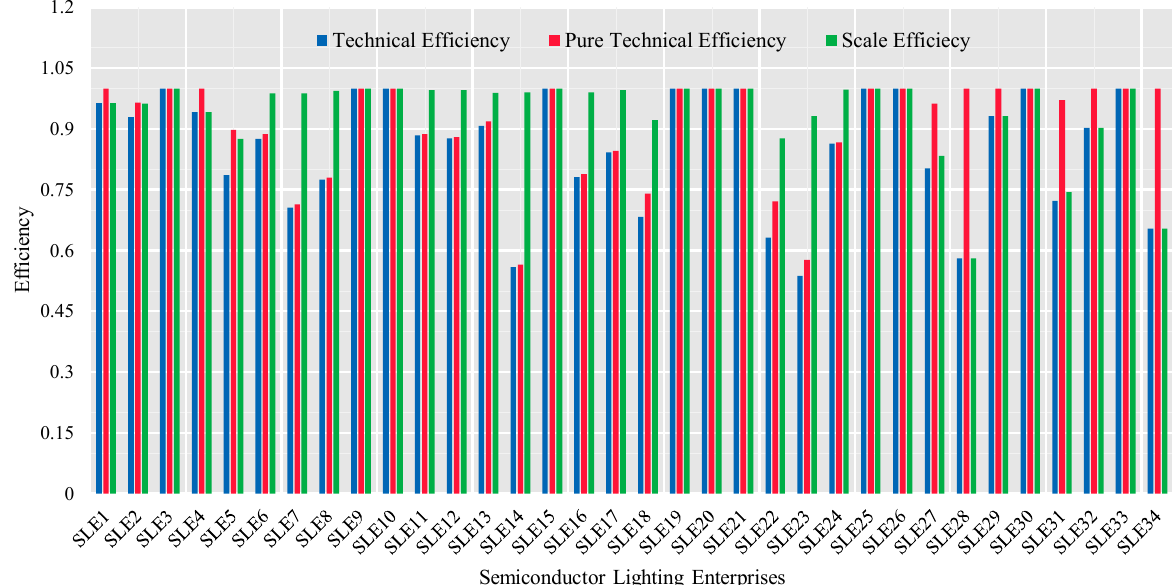
Figure 9. Comprehensive technical efficiency evaluation results of 34 Chinese LED energy enterprises in 2019.